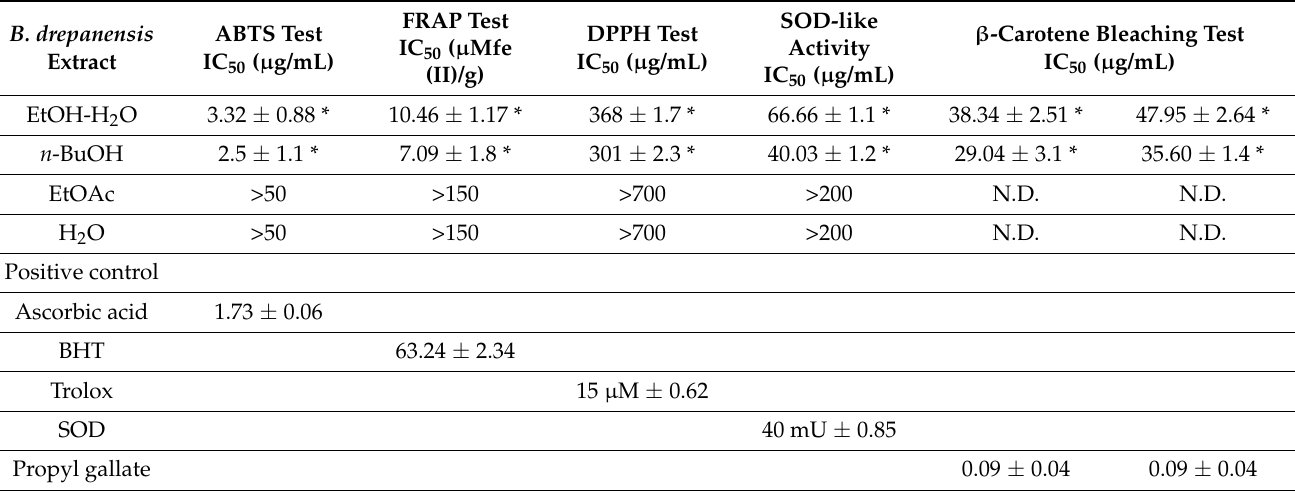
Figure 2. ESI-MS/MS of peaks a and b shown in Figure 1 and tentatively identified as glucoiberin. Table 1. Cell free antioxidant